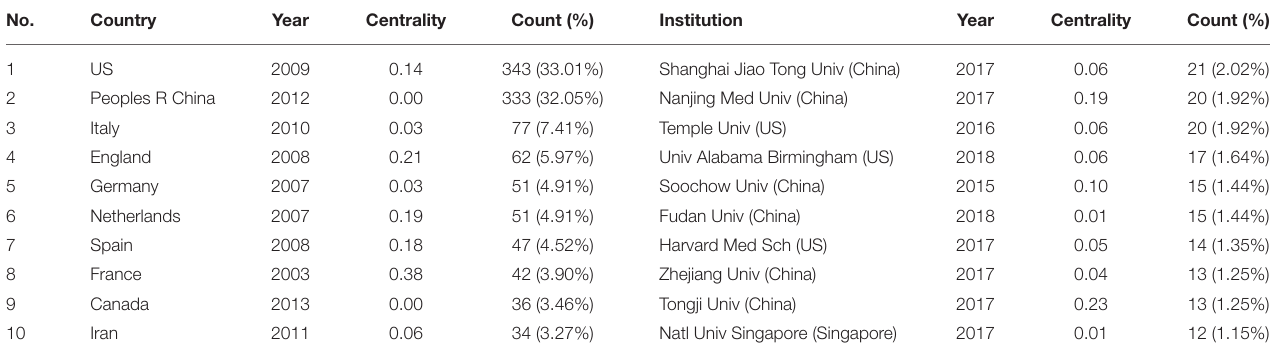
TABLE 1 | Distribution of publications from different countries and